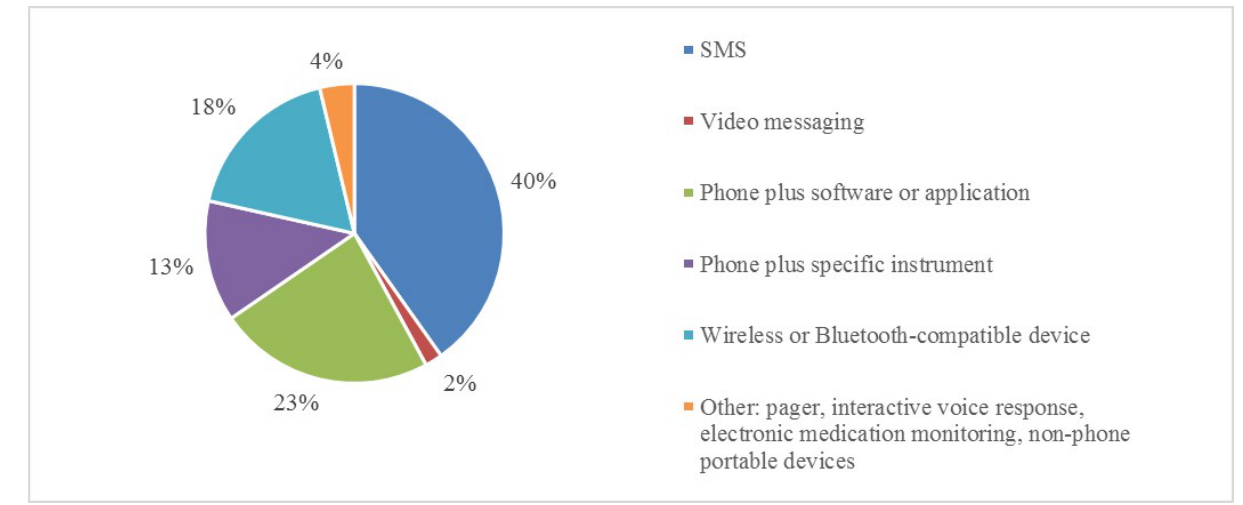
Figure 4. Types of mobile tools used in